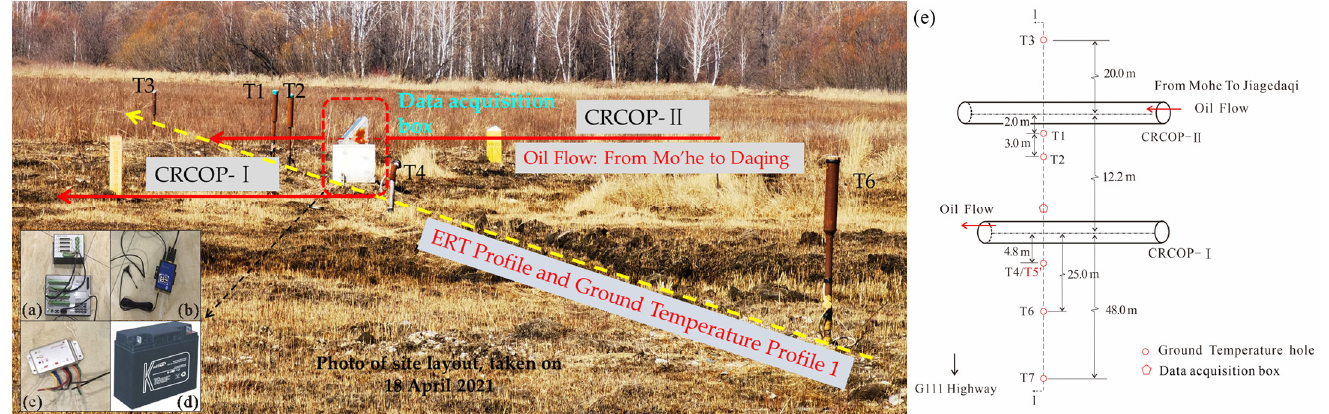
Figure 6. Diagram for the ground temperature monitoring system at the MDS304 site ( e ), ground temperatures are measured using thermistor chains connected to a CR3000 data logger: ( a ) CR3000 data logger with a TRM128 multiplexer, ( b ) Wireless transmission module (HKT-DTU, Campbell Scientific, Inc., Logan, Utah, USA), ( c ) solar charge controller (Phocos ECO (10 A), UIm, Germany), and ( d ) battery cell [51]. The photo was taken on 18 April 2021. Note: T1,…, T7 is a ground temperature borehole; CRCOP-I: the CRCOP’s first line; CRCOP-II: the CRCOP’s second line. Table 2. Ground temperature monitoring information of boreholes near the CROCP at the MDS304 site for Profile 1, from 2011 to 2022.